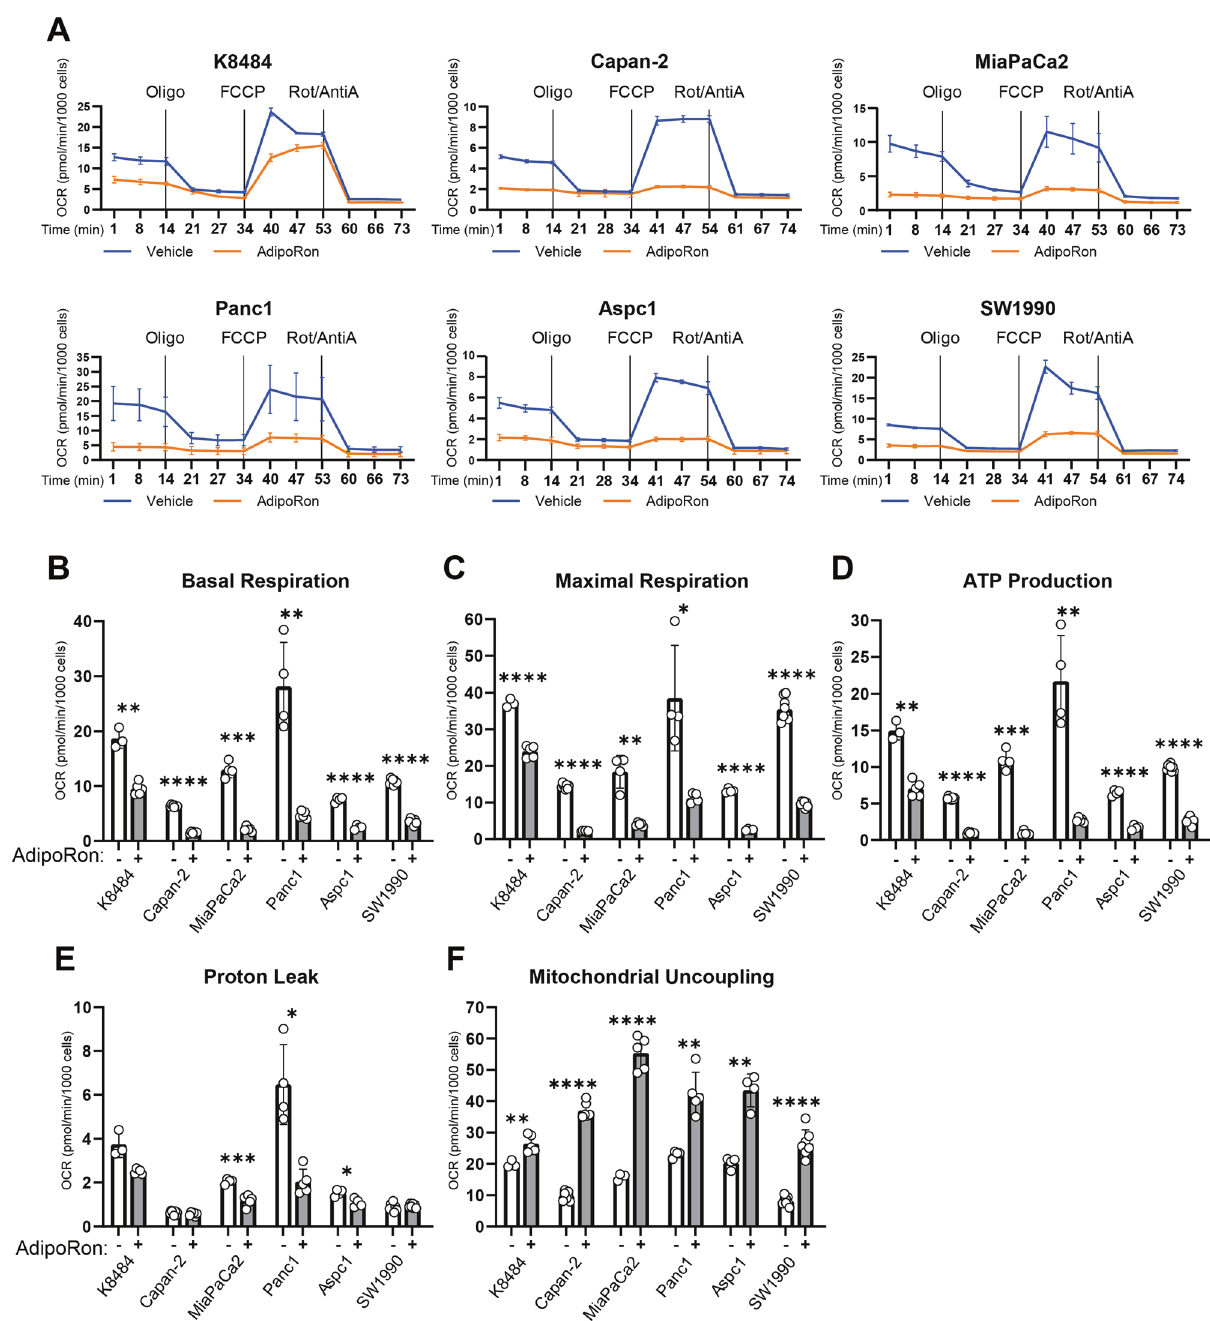
Fig. 2 AdipoRon inhibits mitochondrial respiration and ATP production in pancreatic cancer cells. Seahorse XFe96 bioanalyzer was used to measure oxygen-consumption rate (OCR) in six different PDAC lines ( A ) either untreated or pretreated with 25 μ M AdipoRon for 45 min, with initial basal measurements followed by sequential injections of oligomycin, carbonyl cyanide-4-(tri fl uoromethoxy)phenylhydrazone (FCCP), and antimycin A and rotenone. Basal respiration ( B ), maximal respiration ( C ), ATP production ( D ), proton leak ( E ), and mitochondrial uncoupling ( F ) were calculated from the OCR measurements in ( A ) for the respective cell lines. Statistics: t -test, n ≥ 3; error bars, SD; * P <